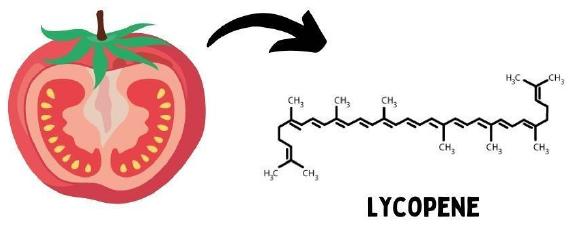
Figure 2. Lycopene found in tomatoes.